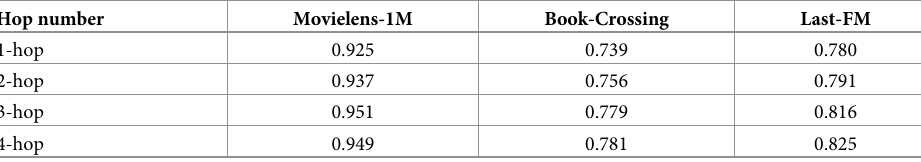
Table 3. Experimental results on AUC of the effect of hop